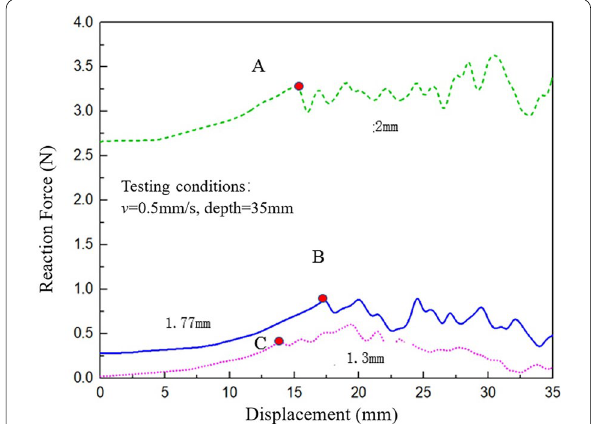
Figure 14 The reaction force of puncture needle with different diameter in the process of